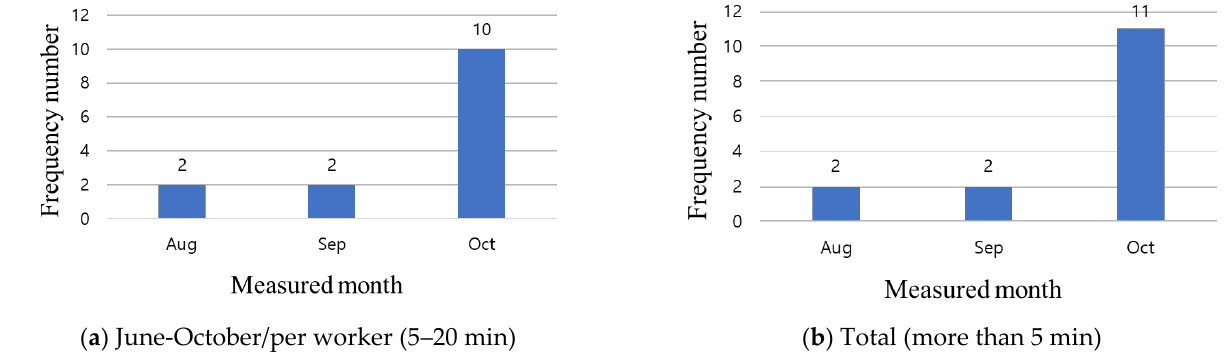
Figure 10. Analysis of FRAA sensor data for B site.